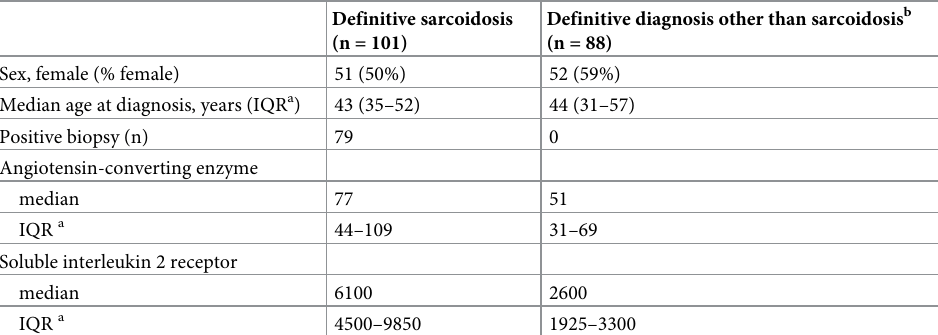
Table 1. Patient